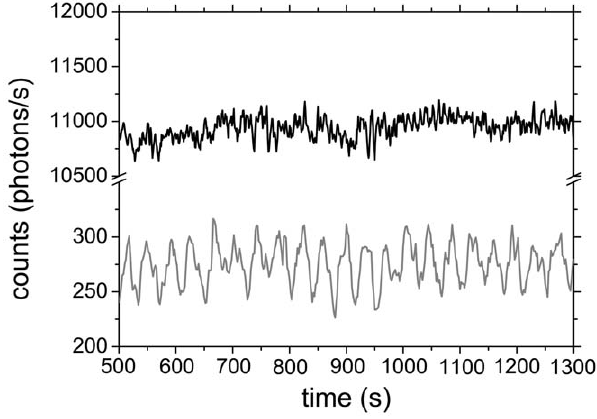
Figure 2. Dynamics of a S.carlsbergensis population of very low density ( r =0.001%). At t =0 an aliquot of 52 mM glucose was added to the starved and immobilised cells. While the collective signal (black line) is quiescent and noisy, long-lasting oscillations are observed in the fluorescence signal emitted by an individual cell (gray line). The original time series were smoothed by adjacent averaging over three consecutive data points.